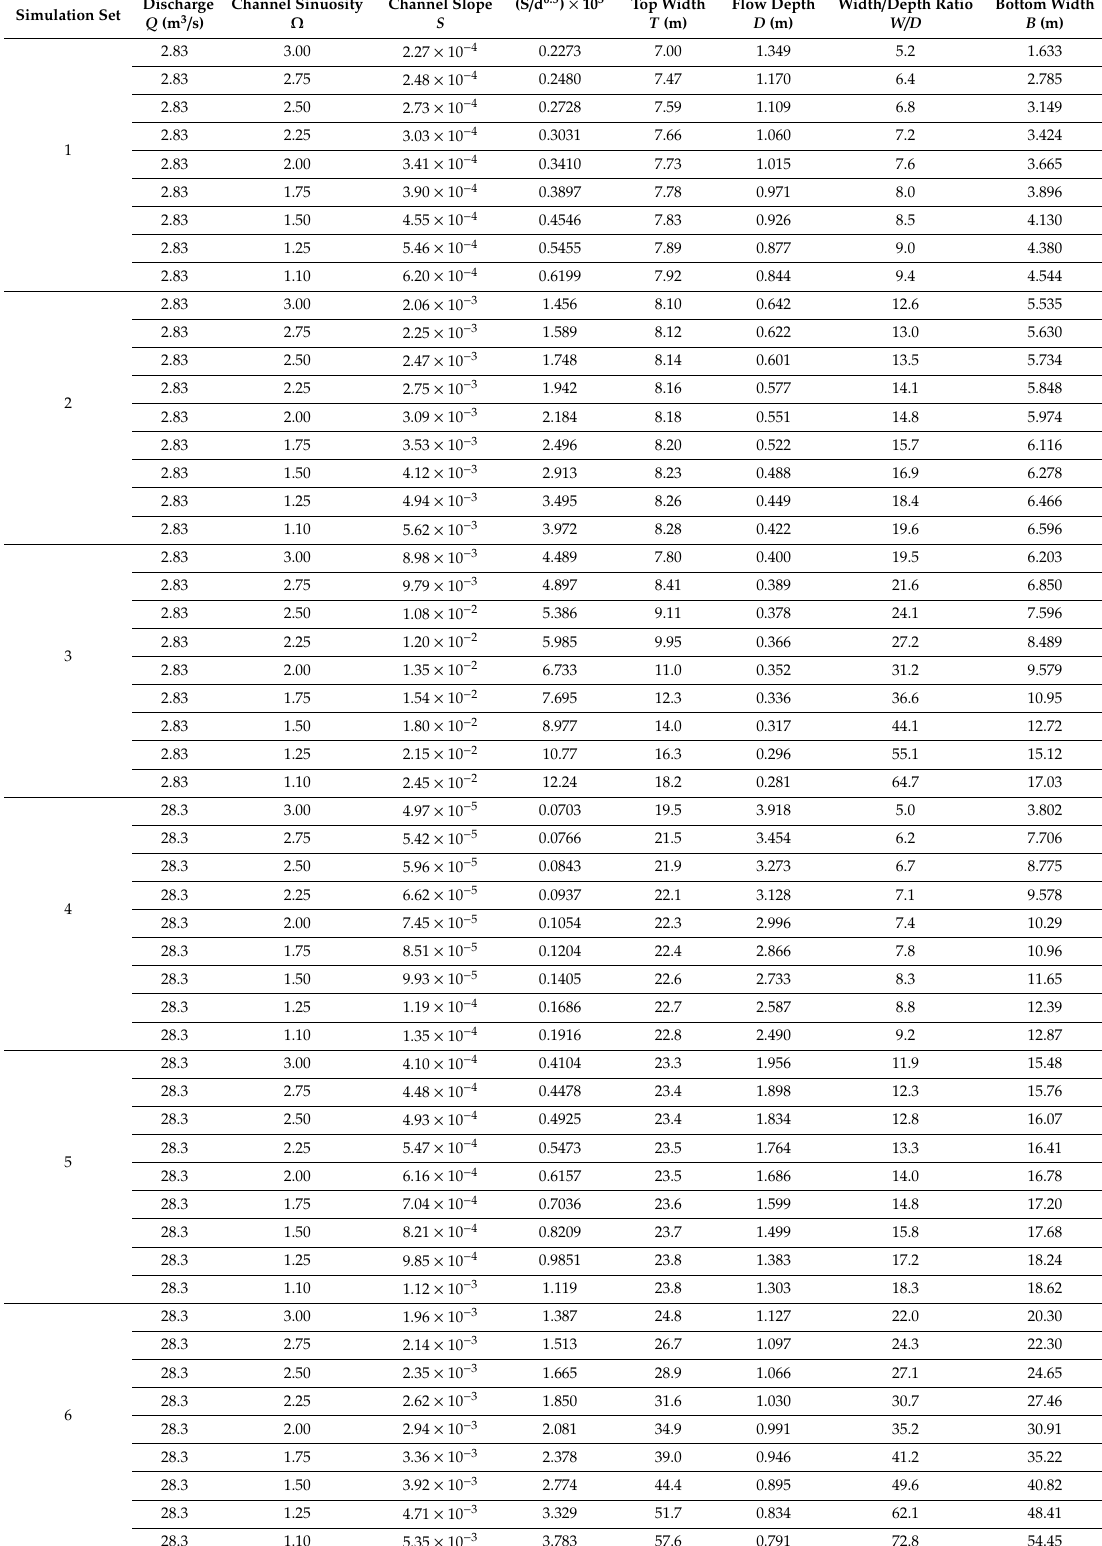
Table A1. Dimensions of synthetic channels for each of twelve simulation sets. Discharge Channel Simulation Set